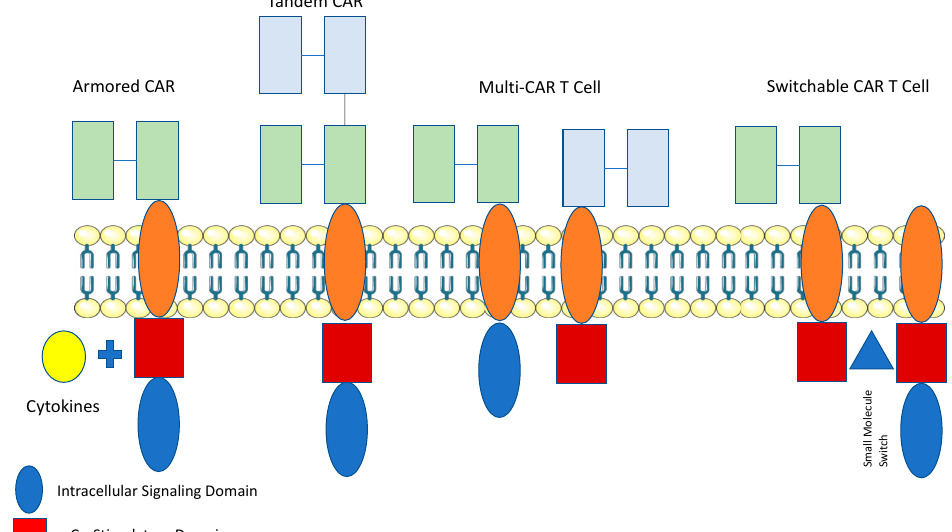
Figure 2. Novel Approaches to Improve CAR T Cell Anti-Tumor Efficacy. Armored CAR T cells have been designed to protect T cells from the immunosuppressive tumor microenvironment by expressing cytokines, as an independent gene within the CAR vector. Tandem CAR T cells have been designed to express two antigen-binding domains arranged in tandem with one intracellular signaling domain. Multi-CAR T Cells consist of one T-cell expressing two CAR structs with different antigen binding domains, with one CAR containing an intracellular and the other a co-stimulatory domain. The presence of both antigens is required to efficiently activate the T cell. Switchable CAR T cells expresses a CAR joined to a co-stimulatory signaling domain. The CD3- ζ intracellular signaling domain can heterodimerize with the CAR co-stimulatory domain only in the presence of a small molecule which acts as an ‘ON’ switch. Thus, both interaction with target antigen and the small molecule are required for activation of the CAR T-cell. This figure was created with images adapted from Servier Medical